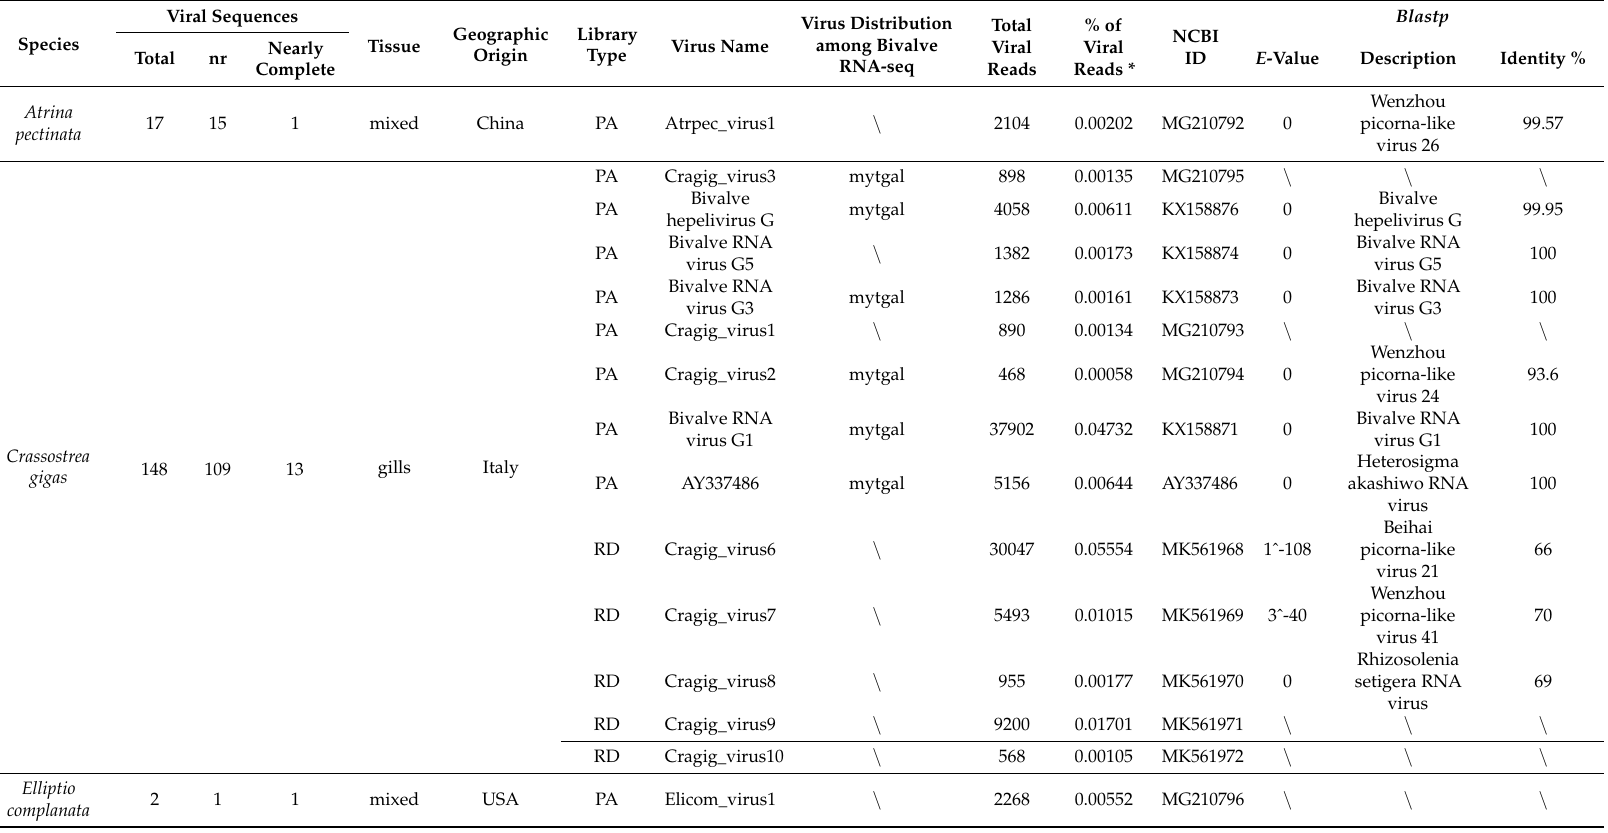
Table 2. Summary of the 26 nearly complete viral genomes. Bivalve species, total number of viral sequences, non-redundant (nr) sequences, and number of “nearly complete viral genomes” are reported. Sequenced tissue and geographical origins of the RNA samples, library type, virus name, and virus distribution in transcriptomes of other bivalves and virus coverage are also reported (as is the total number of viral reads, and as a percentage over the total reads). The BLAST similarities are reported with the E -values, NCBI ID, and the description and percentage of